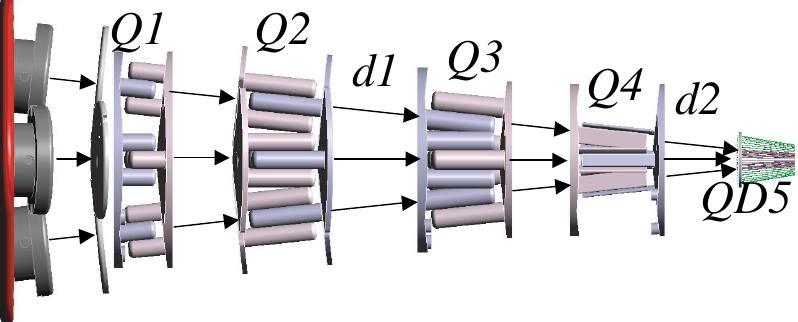
FIG. 1. (Color) A CAD view of the lattice elements of the Combiner apparatus. Diagnostics are at locations marked d 1 and d 2 . The first four elements ( Q 1 – Q 4 ) are electrostatic quadrupoles. Each of the quadrupoles of Q 2 is separately moveable in both horizontal and vertical dimensions. QD 5 is the combined function dipole and quadrupole, for which the electrostatic field-defining rods around each beam converge as z increases. The distance from the source emitting surfaces to the end of QD 5 is (cid:3) 108 cm .